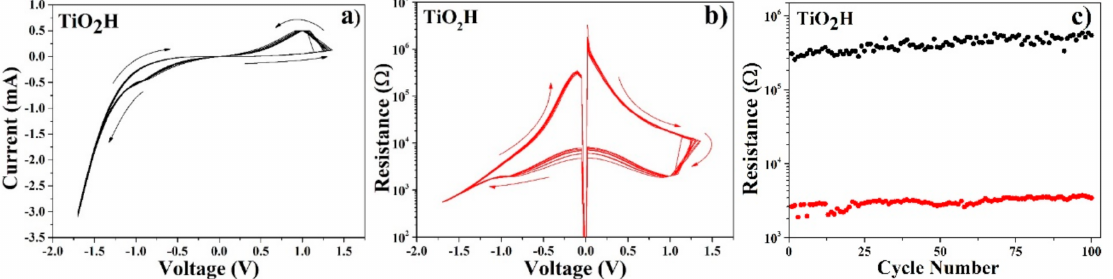
Figure 6. Typical electrical characteristics of TiO 2 H device, having Pt discs as a top electrode. I-V ( a ), R-V ( b ) curves together with device life ( c ; R OFF black dots, R ON red